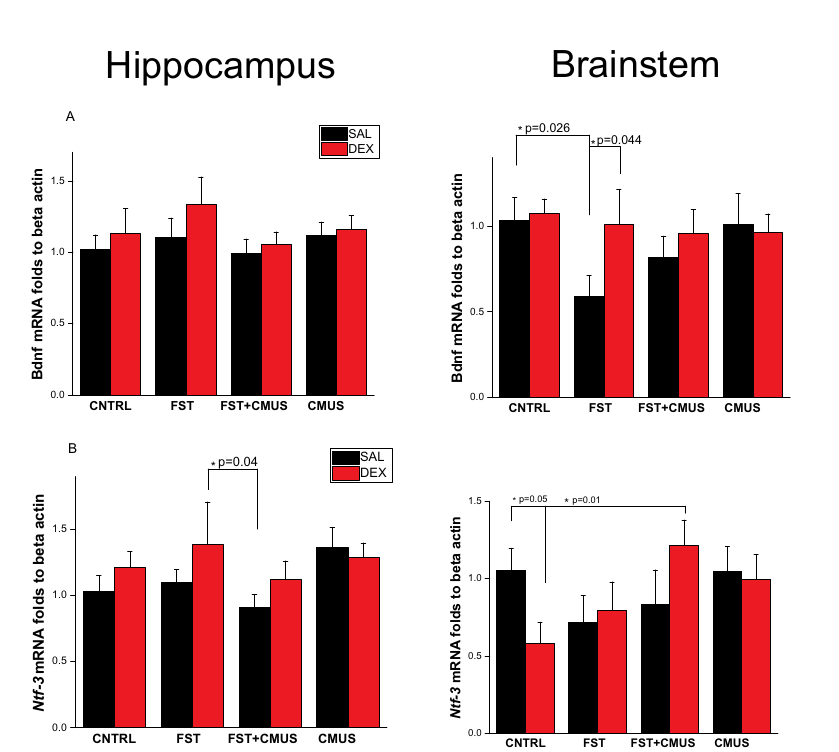
Figure 5. Stress reactive expression of Bdnf- ( A ) and Ntf3- ( B ) at P60 in the hippocampus and brainstem after neonatal DEX administration and chronic mild stress (CMUS) at the end of adolescence. TWO WAY ANOVA * p < 0.05, Data are presented as M ±